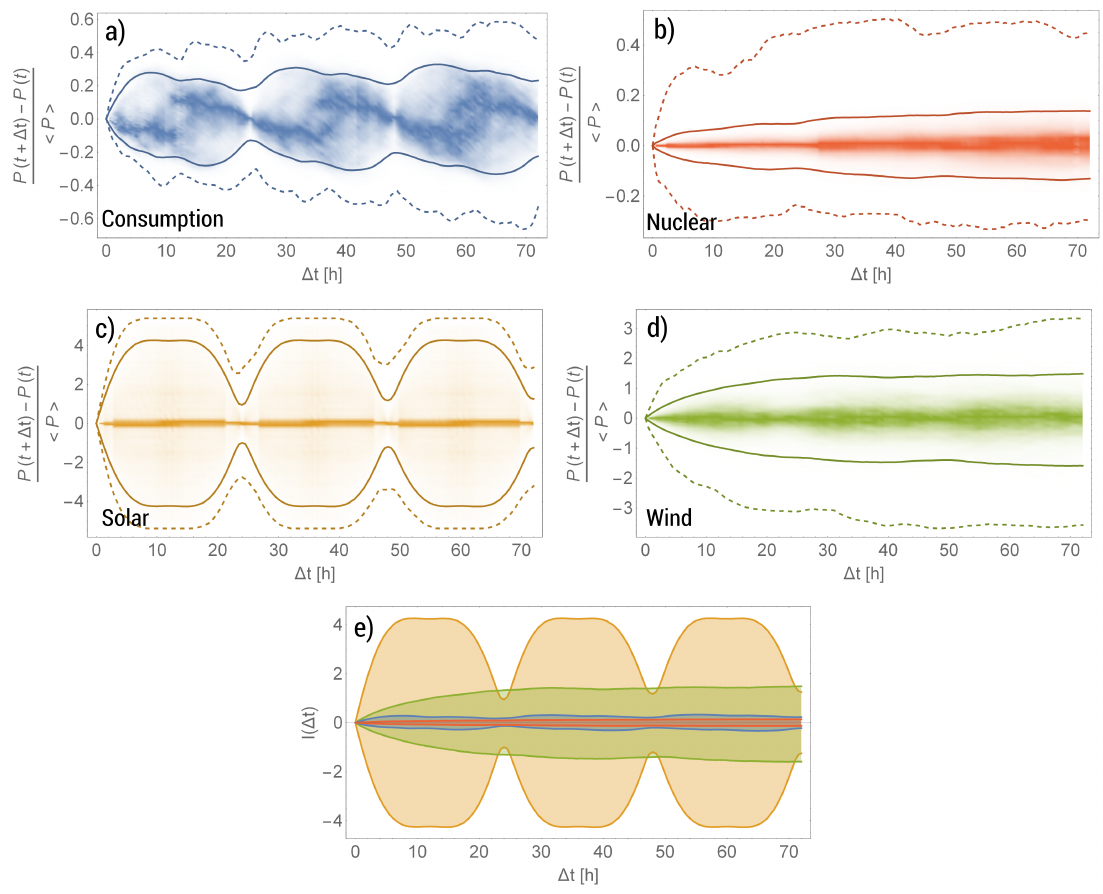
Figure 2. Indicator for intermittency over time. ( a ) consumption (blue); ( b ) nuclear (red); ( c ) solar photovoltaic (PV) (yellow); ( d ) wind (green). The solid lines correspond to I ( ∆ t ) as defined here, that is, the 5th and 95th percentiles where 90% of the most central points lie (see horizontal bar in Figure 1). The dashed lines give the extreme variations (see dashed vertical lines in Figure 1). The shading intensity at each point is proportional to the probability density function at this point (the darkest region corresponding to the mode), so that a slice at a given ∆ t is a “top view” of the corresponding histogram, as presented in Figure 1. The last figure ( e ) combines the previous figures to ease comparisons. Let us recall that, despite a possible resemblance to the daily power profiles, we display here the variations of consumption at all instants t of the year, and for a variable ∆ t . The relatively small inter-percentile interval of consumption at ∆ t (cid:39) 24 h, for example, has no connection with the fact that consumption is low at t (cid:39) 24 h